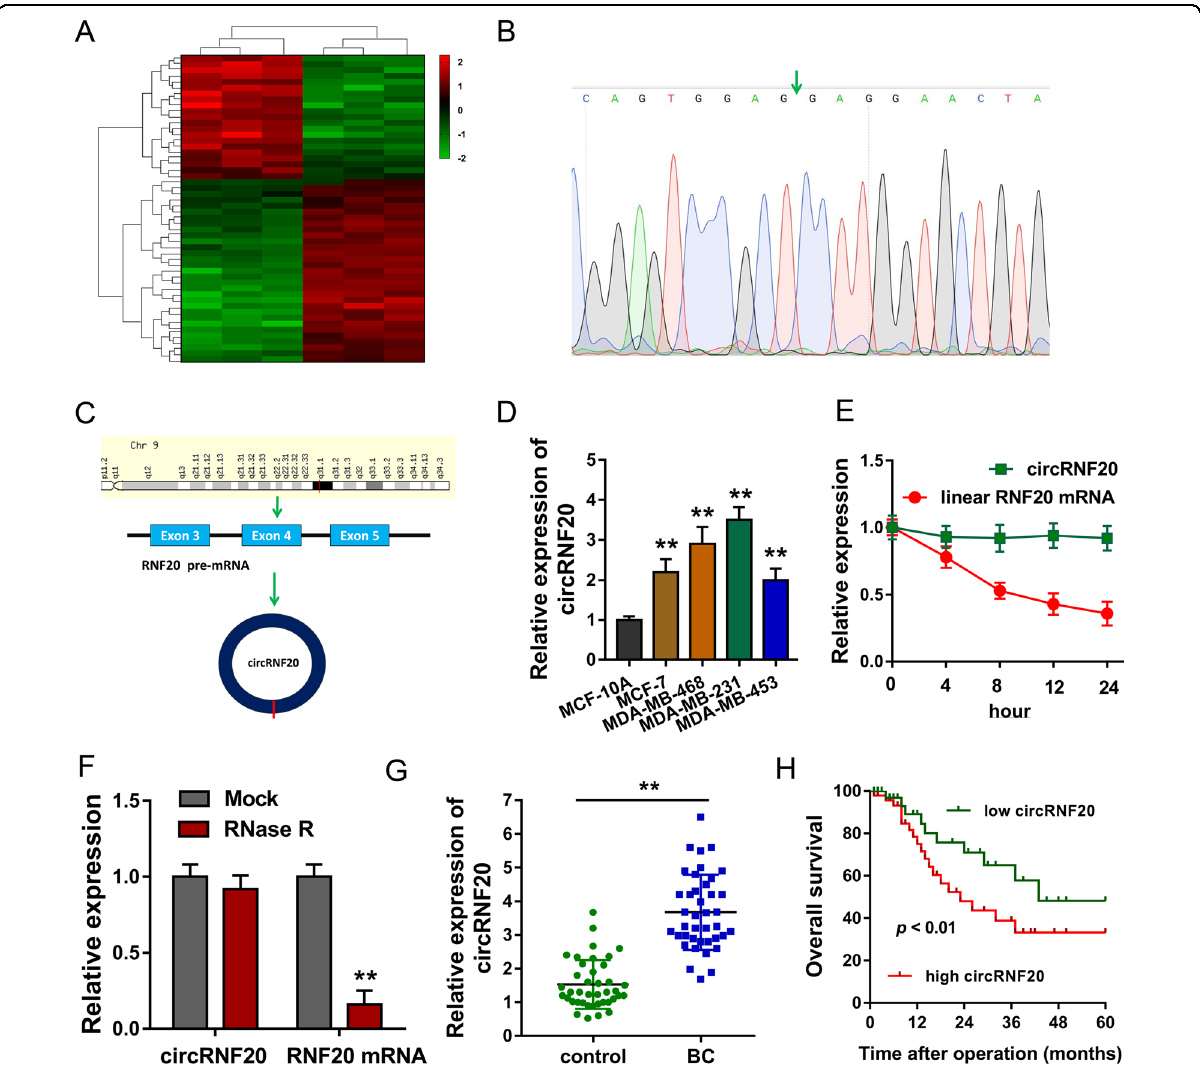
Fig. 1 circRNF20 is upregulated in the BC tissue and cells. a Heat map showed the upregulated circRNAs and downregulated circRNAs. b Sanger sequencing illustrated the joint site of circRNF20 (3 ’ -end of exon 5 and 5 ’ -end of exon 3). c Schematic diagram illustrated the formation of circRNF20 originated from RNF20 pre-mRNA (exon 3, 4, 5). d RT-PCR revealed the expression of circRNF20 in the BC cell lines. e RNA stability assay found the expression of circRNF20 or linear mRNA transcript in MDA-MB-231 cells under treatment with transcription inhibitor (actinomycin D). f RT-PCR showed the expression of circRNF20 and RNF20 mRNA in MDA-MB-231 cells administered with RNase R or Mock control. g RT-PCR showed the circRNF20 level in the BC tissue. h Prognosis analysis calculated by Kaplan-Meier and log-rank test unveiled the survival rate of BC patients with higher or lower circRNF20 expression. ** p < 0.01 vs.